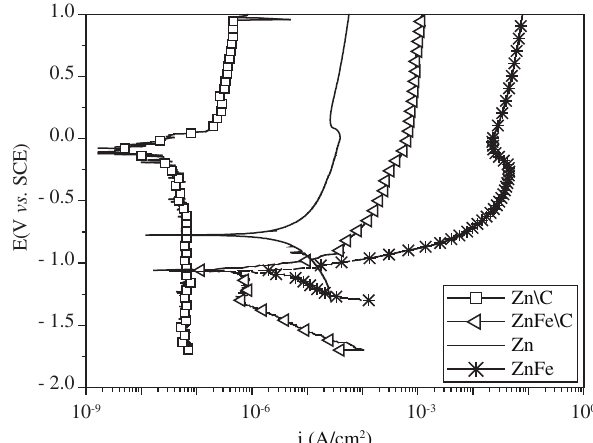
Figure 6. Evolution of polarisation resistance with time for all systems (coated and uncoated samples).